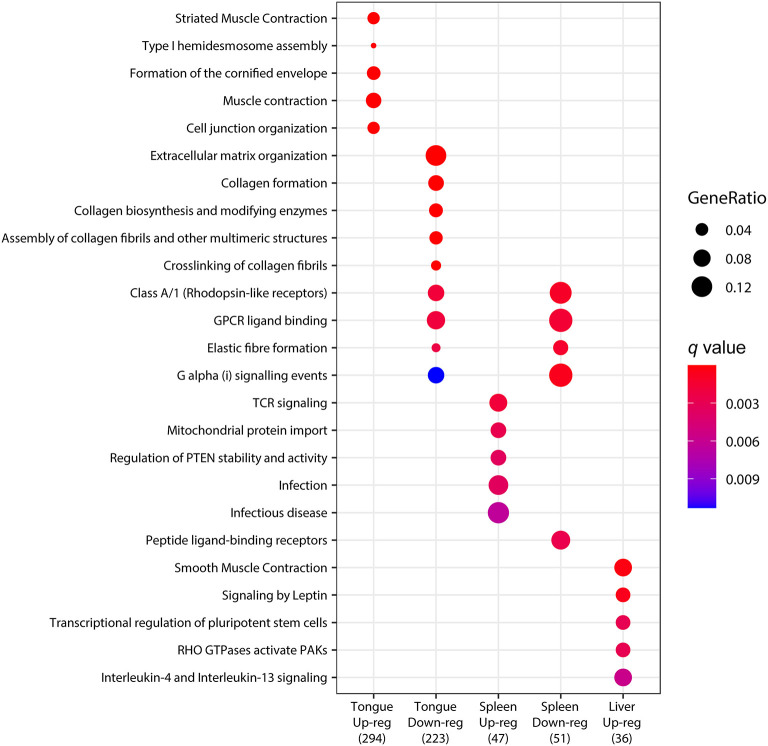
Dotplot pathway enrichment map showing the most significantly over-represented pathways for each set of upregulated or downregulated genes in each organ when comparing Ceratothoa-infected against CTRL Dicentrarchus labrax samples.